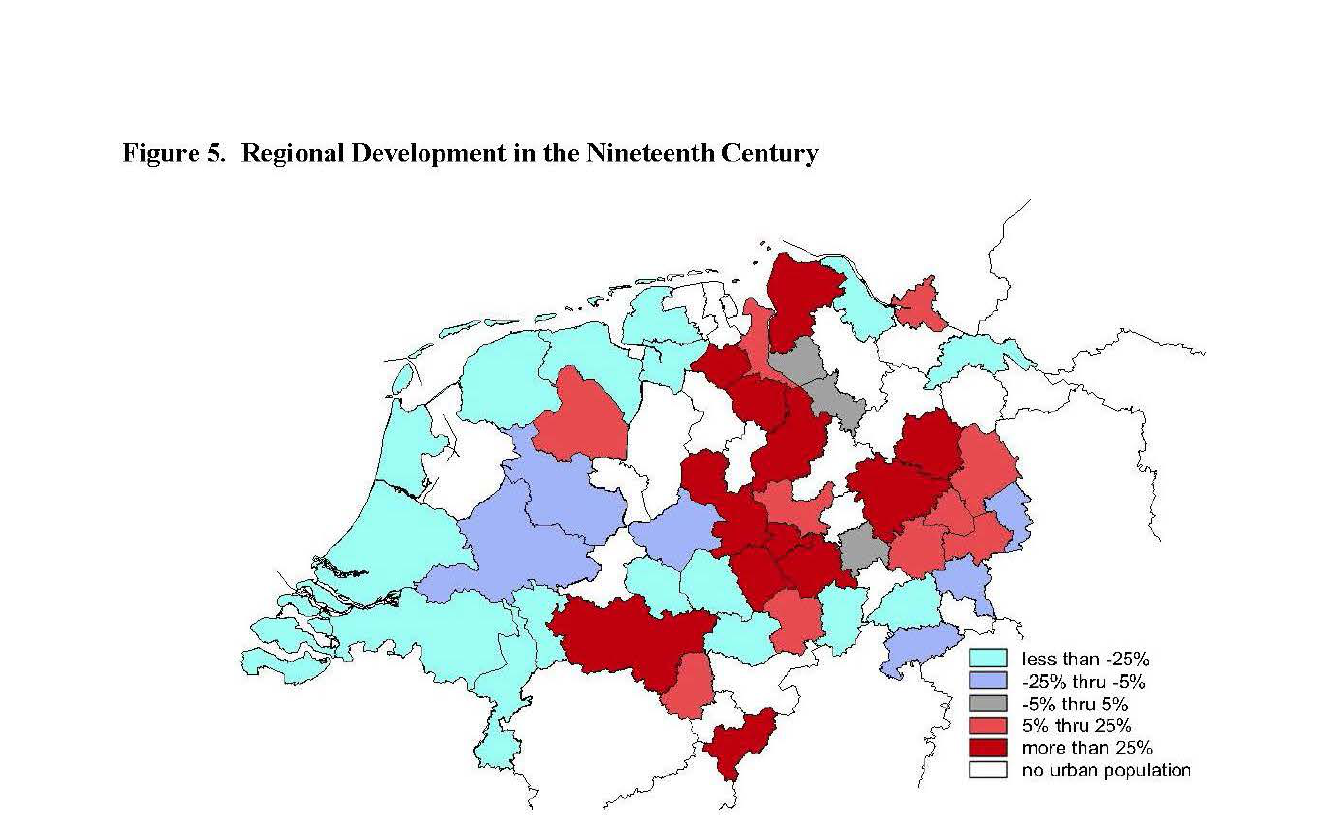
Figure 5. Regional Development in the Nineteenth